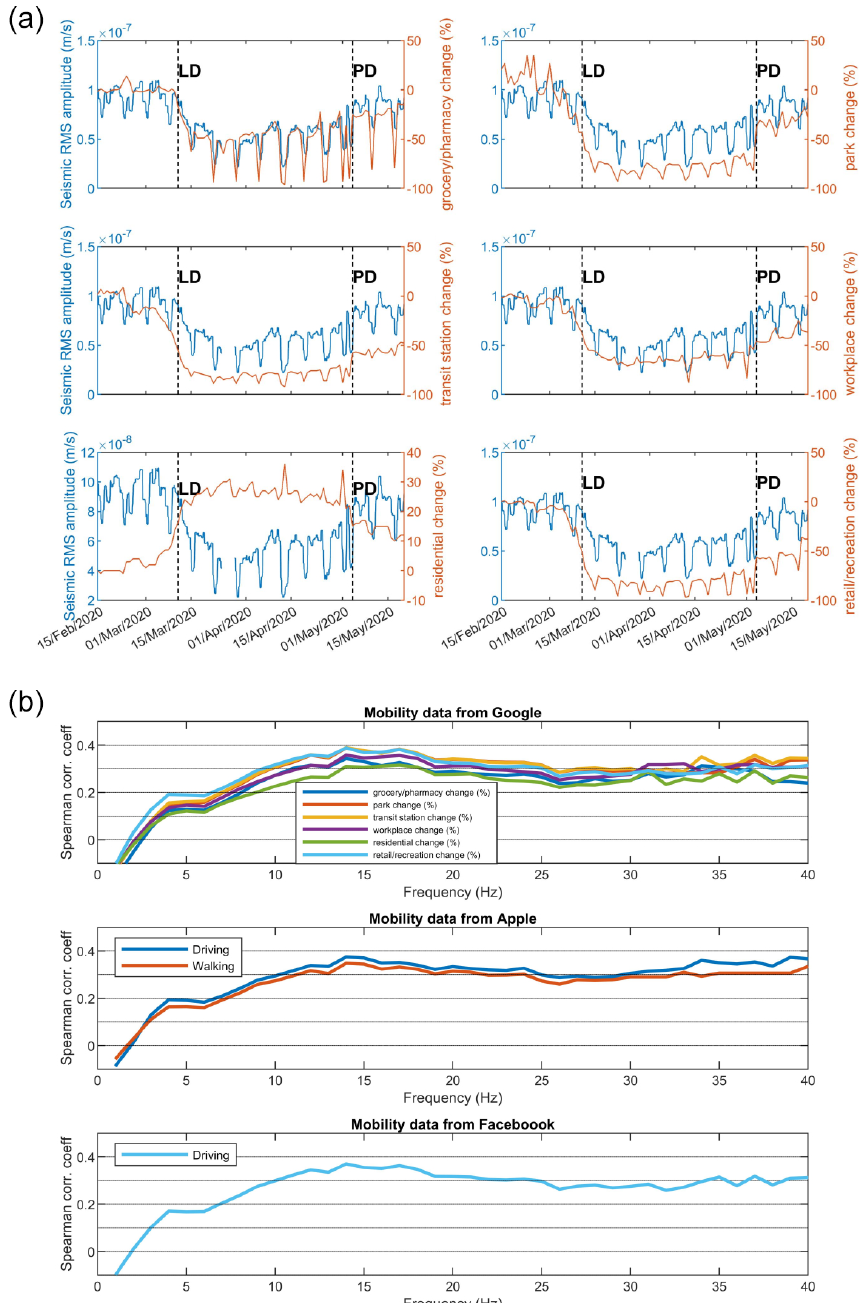
Figure 9. (a) Time series of rms amplitude of the vertical component of the seismic signal recorded by EFIU station and filtered in the band 10–40Hz (blue line) and the different categories of human mobility as provided by Google (red line). The vertical dashed lines and the labels “LD” and “PD” indicate the times when the national lockdown measures were implemented in Italy (11 March 2020) and when the first presidential decree, slightly lifting the lockdown measures, was issued (4 May 2020), respectively. (b) Spearman correlation coefficient, calculated between seismic rms amplitude at the different stations and the mobility parameters, as a function of the frequency band of the seismic noise. The Spearman correlation coefficient obtained for the residential change (top plot in b ) was multiplied by − 1 to make it positive.